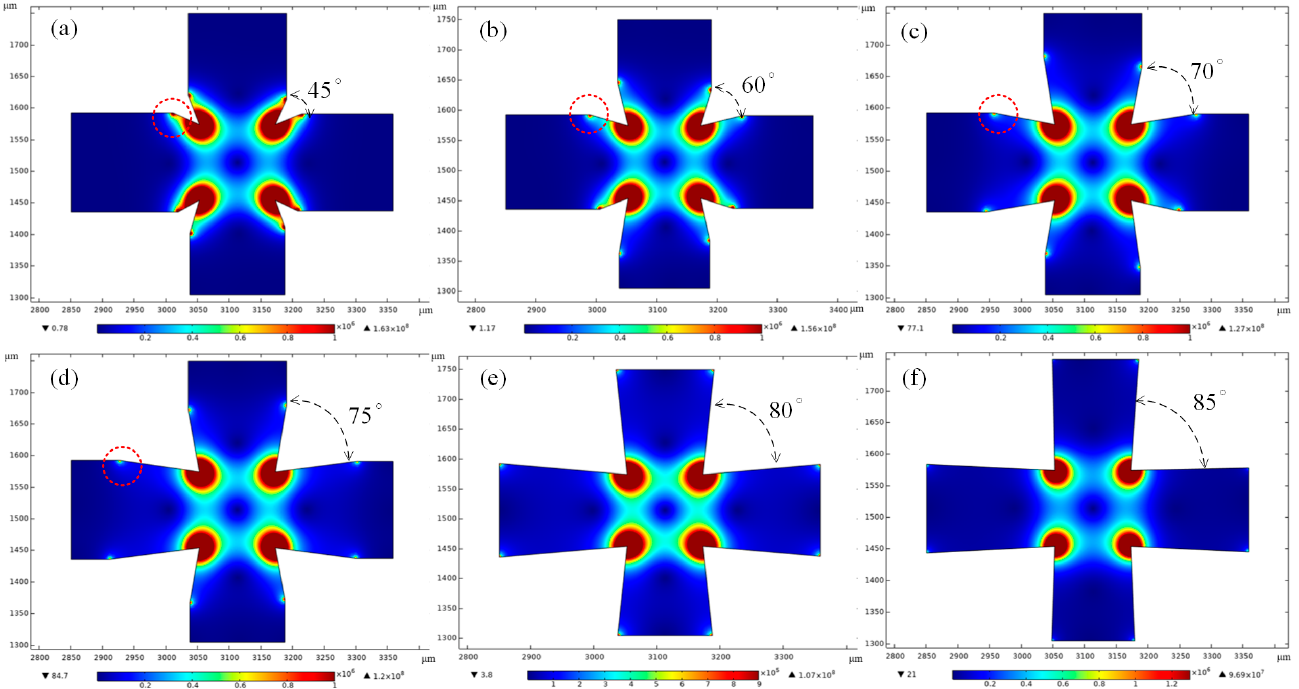
Figure 3. Simulation of electric field intensity gradient of a triangular electrode at different angles (V 2 /m 3 ); ( a ) 45 ◦ , ( b ) 60 ◦ , ( c ) 70 ◦ , ( d ) 75 ◦ , ( e ) 80 ◦ , and ( f ) 85 ◦